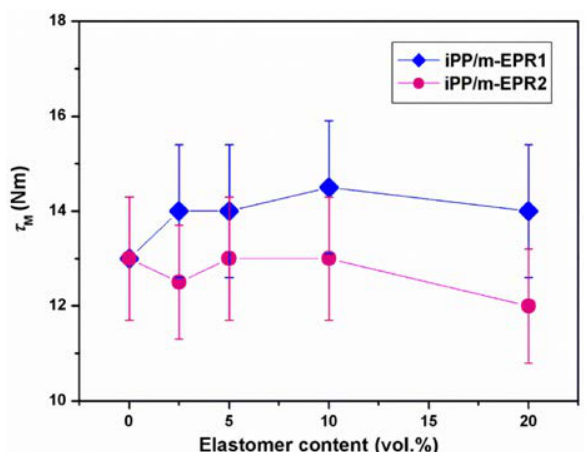
Figure 1. Steady state torque of the iPP/m-EPR blends in depend- ance on volume content of added elastomers